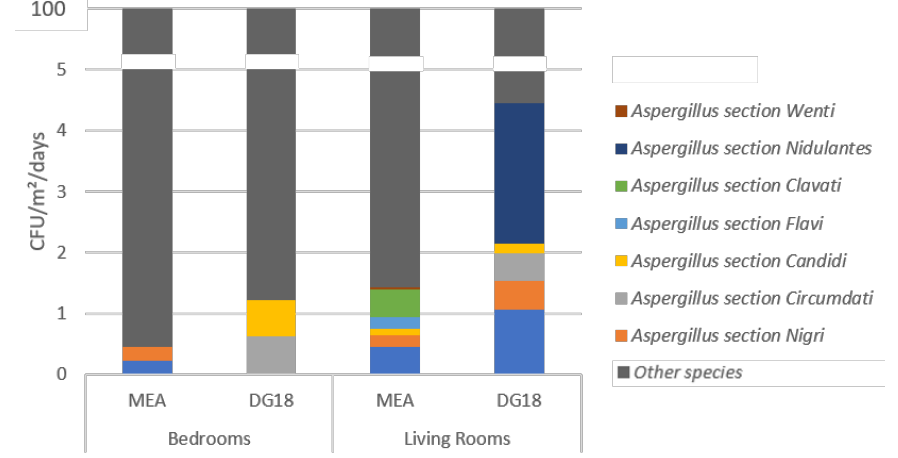
Figure 2. Aspergillus sections identified in the electrostatic dust collectors (EDC) samples from the bedrooms and the living